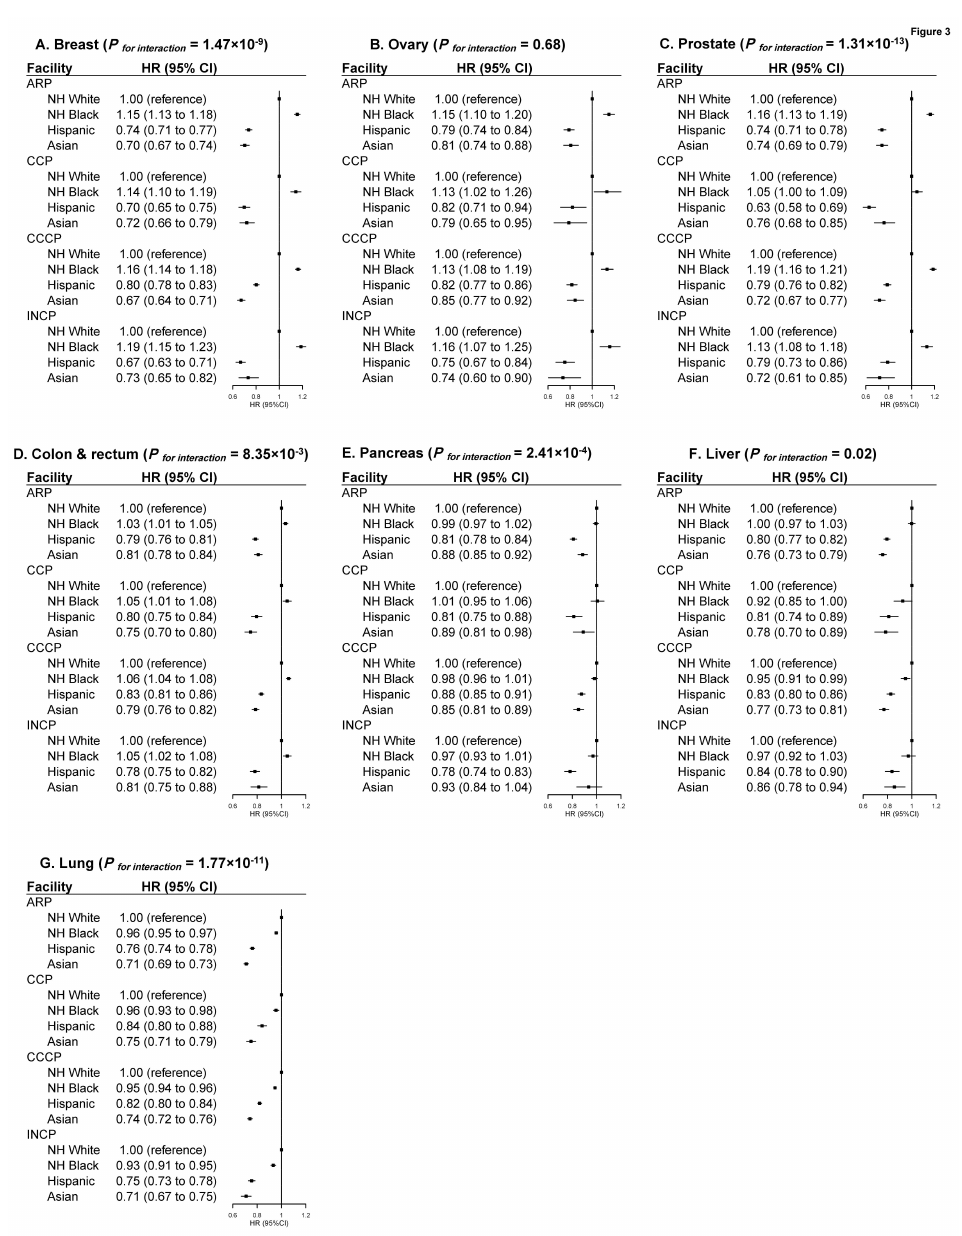
Figure 3. Multivariable-adjusted HRs and 95% CIs for Total Mortality Associated with Race/ethnicity According to Treating Facility Type in Major Cancer Types. The HRs and 95% CIs for total mortality associated with race/ethnicity according to treatment facility type in major cancer types (( A ) Breast Cancer; ( B ) Ovarian Cancer; ( C ) Prostate Cancer; ( D ) Colorectal Cancer; ( E ) Pancreatic Cancer; ( F ) Liver Cancer; ( G ) Lung Cancer). The HRs and 95% CIs were adjusted for age, sex (if applicable), biology (histology type, grade, TNM stage, LVI, comorbidity; ER, PR, HER2 for breast cancer; CA 125 for ovarian cancer; PSA and Gleason grade for prostate cancer; CA 19-9 for pancreatic cancer; AFP, Fibrosis Score, INR for liver cancer; separate tumor nodules for lung cancer; primary site, CEA, circumferential resection margin for colorectal cancer), treatment factors (surgery, chemotherapy, interval between diagnosis to first treatment; and endocrine therapy, radiation, immunotherapy, if applicable) and access to care (education, income, insurance, region, urban/rural residence, distance to care, and year of diagnosis). p values for interaction between racial/ethnic groups and facility groups were derived from log likelihood tests. Cancer patients with unknown treatment facility type were not included in this analysis. Abbreviation: HR, Hazard Ratio; CI, Confidence